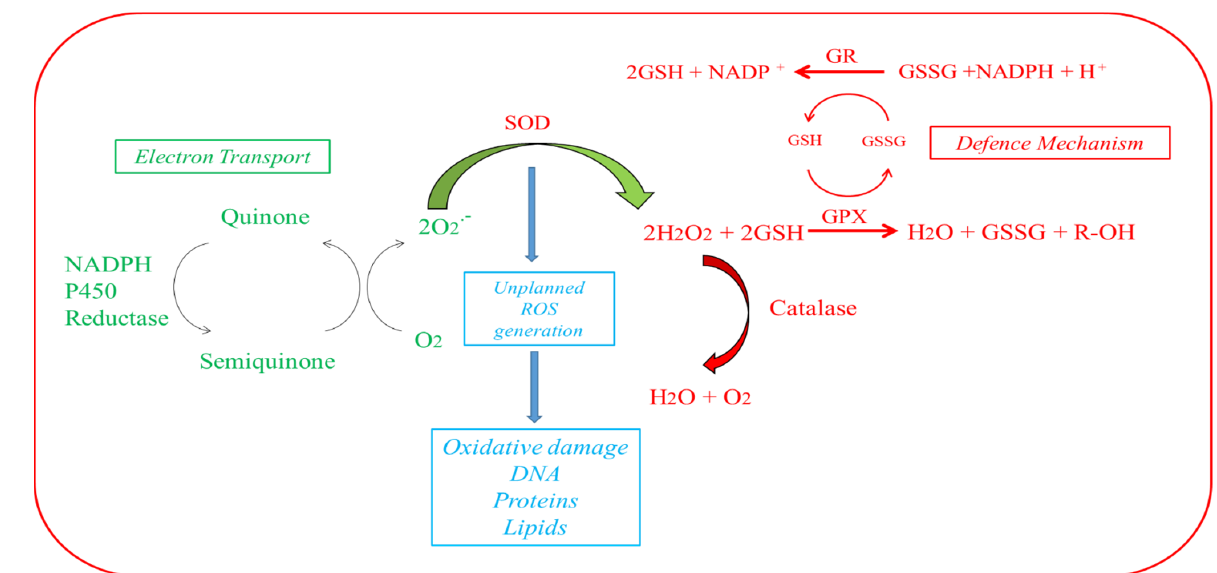
Figure 1. The schematic diagram of ROS action on DNA, protein, and lipid in the microalgae cell body.